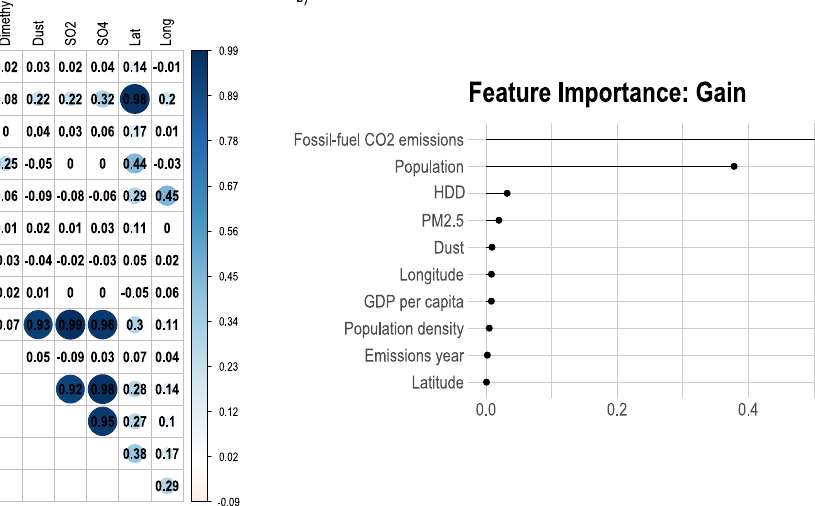
The more an attribute is utilized to make decisions in the XGBoost model, the higher its feature importance is